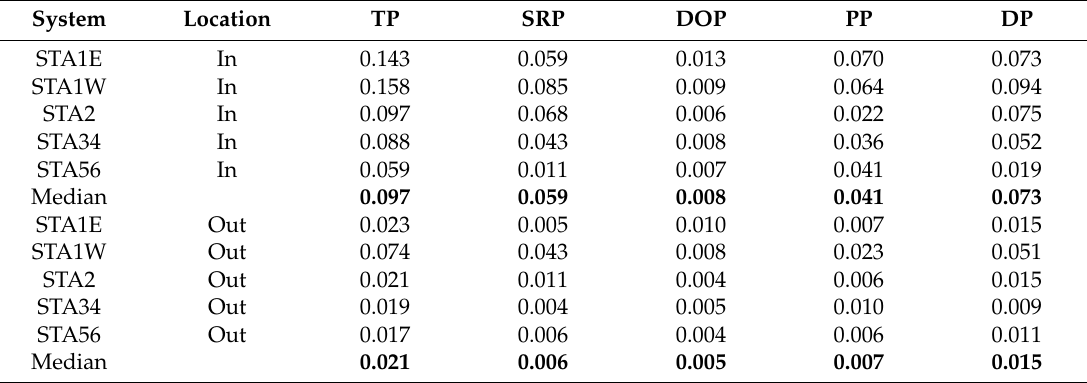
Figure 7. Monthly performance of the Apopka Wetlands over a ten-year POR. The average hydraulic loading was 10.3 cm/day. PP is reduced in all months, but dissolved P is increased. Overall TP reduction is greater in the first six months of the year (34%, and much less in the second six months (2%). Soluble reactive phosphorus pulses are rapidly consumed in wetlands [46,47]. Juston and DeBusk (2011) [48] measured P species on multiple-point transects over multiple years in STA2 Cell 3. The internal P speciation profile showed that SRP was reduced to the analytical detection limit more quickly than DOP or PP, and that SRP was reduced to lower levels. As a result, SRP exiting the STAs is frequently at the minimum detection level (Table 3). Table 3. Phosphorus speciation in water entering and leaving the stormwater treatment areas (STAs) during a POR ending in 2007 (gP·m − 3 ).